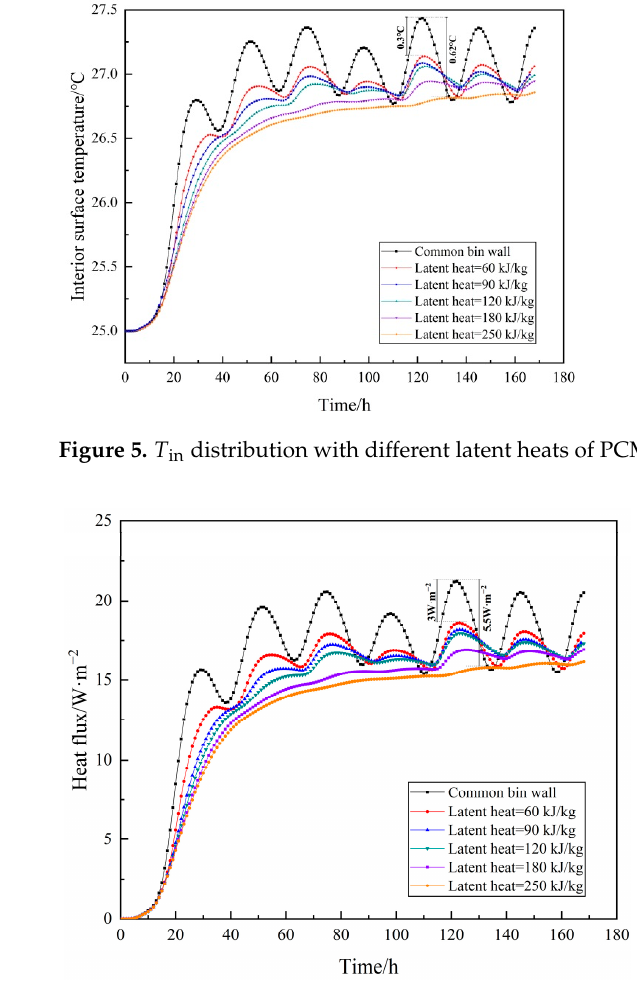
Figure 7. Heat gain and energy saving of PCM (Guangzhou). 3.2. Effects of Phase Change Temperature of PCM The outdoor temperature will greatly affect the phase change temperature in differ- ent climate regions. Thus, all cases in the three cities were studied. The hourly indoor